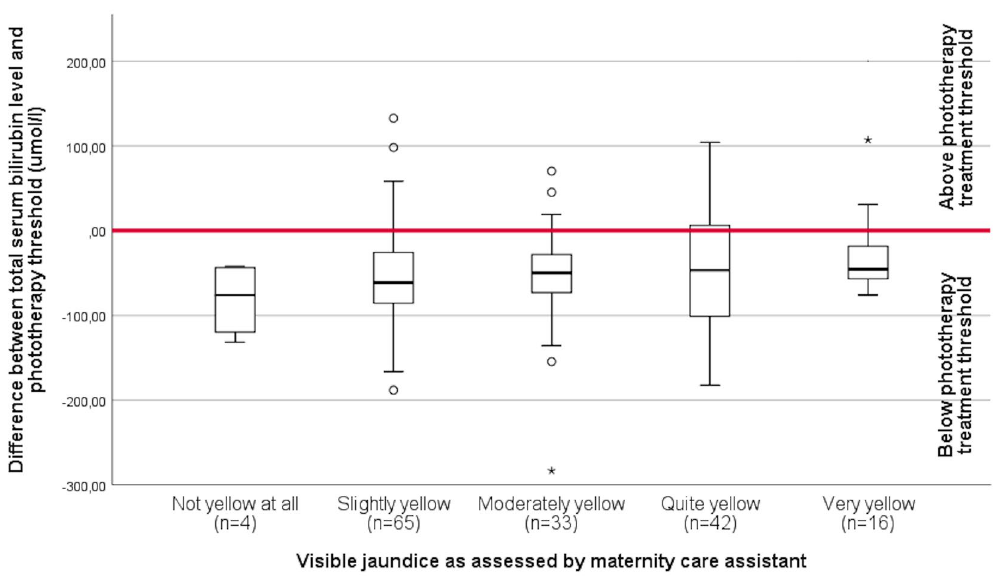
Figure 3. Difference between individual phototherapy treatment threshold and total serum bilirubin level according to degree of jaundice as visually assessed. The area above the red bar indicates a total serum bilirubin level above phototherapy treatment